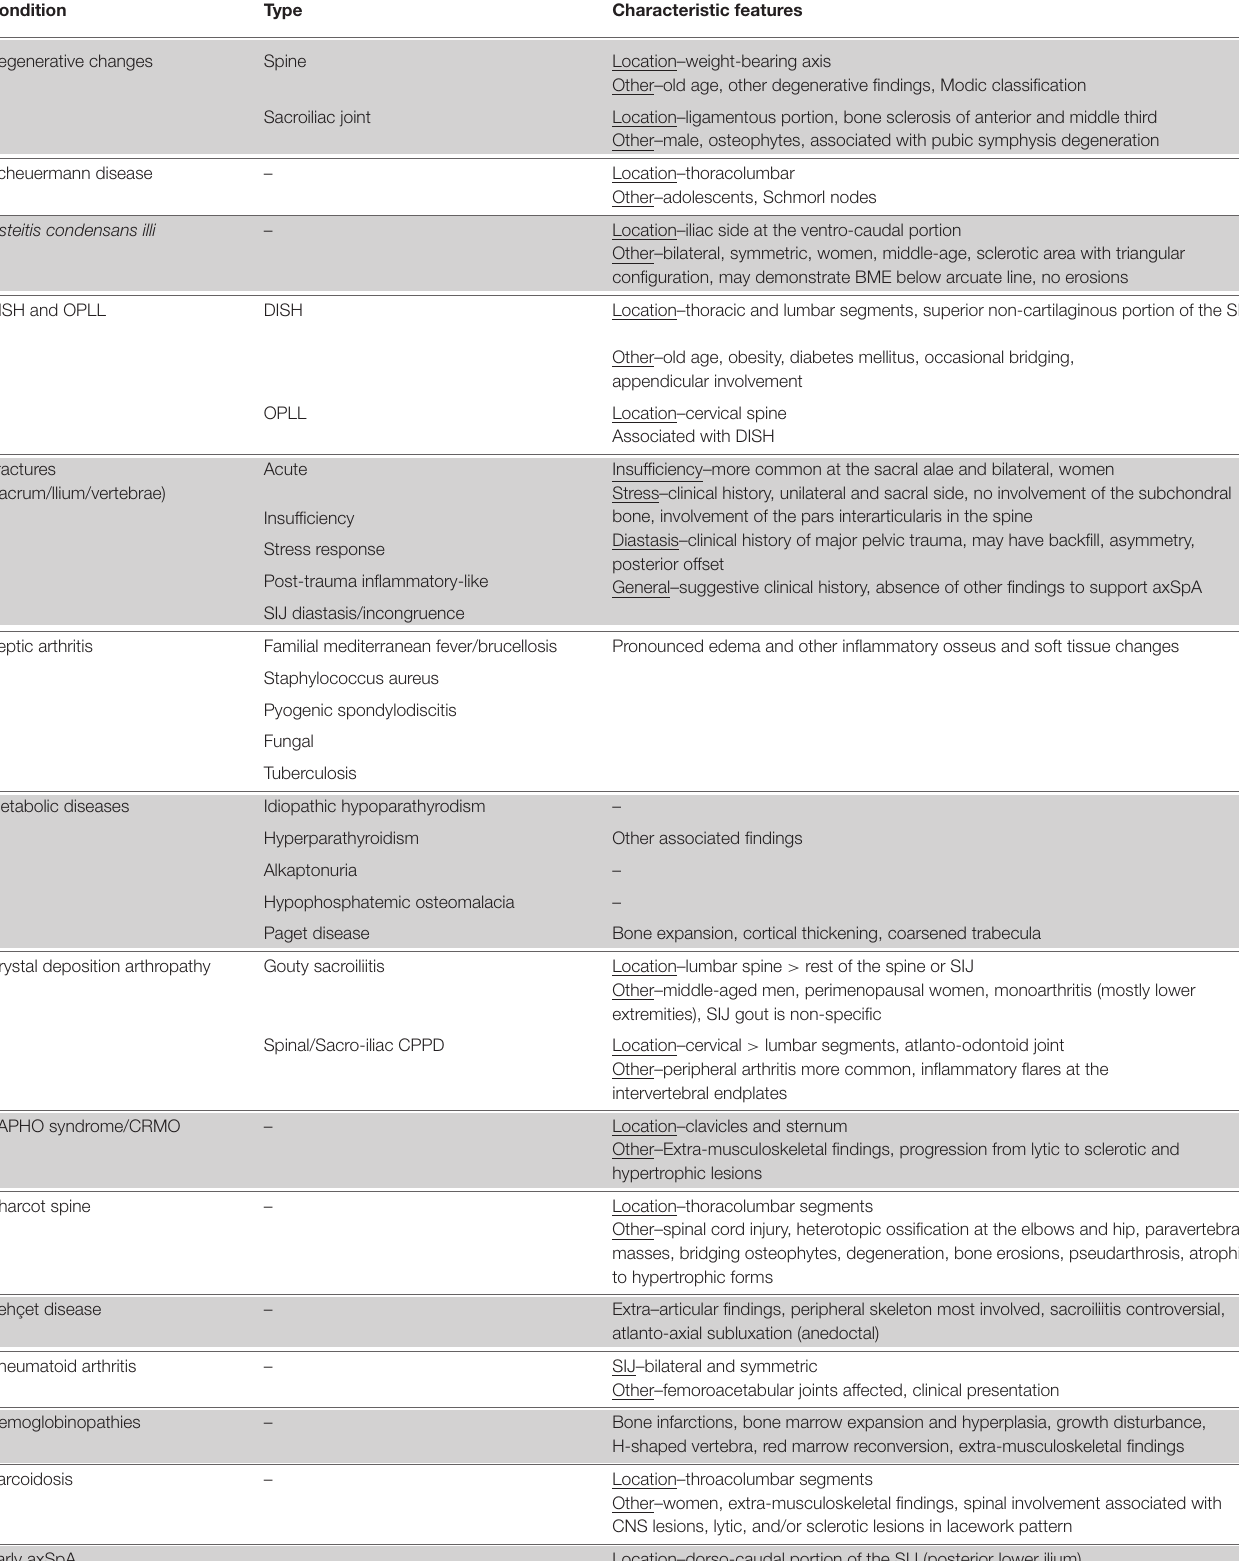
TABLE 3 | Pathological conditions that mimic axial spondyloarthritis.